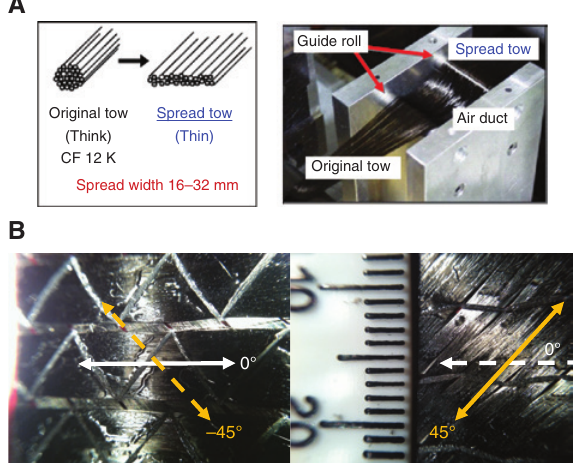
Figure 2: (A) Tow-spreading technique [15]; (B) Bi-angle thin-ply NCF pre-preg C-ply™ with Aldila’s AR2527 resin: (− 45/0) (left) and its flipped-over look as (0/45)